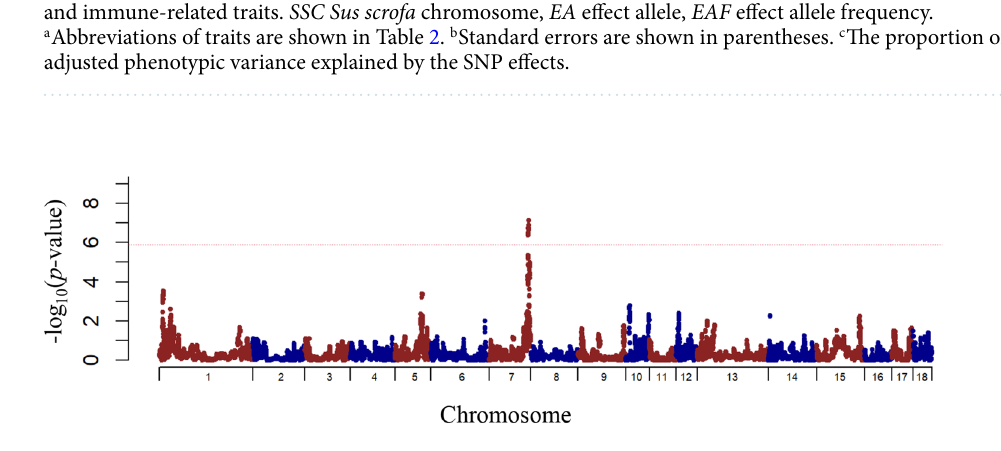
Figure 2. Manhattan plot representing the haplotype-based genome-wide significant association with cortisol at 105 kg body weight in Landrace pigs. The x-axis indicates the chromosome number and the y-axis indicates –log 10 ( p -value). The dotted horizontal line indicates the significant